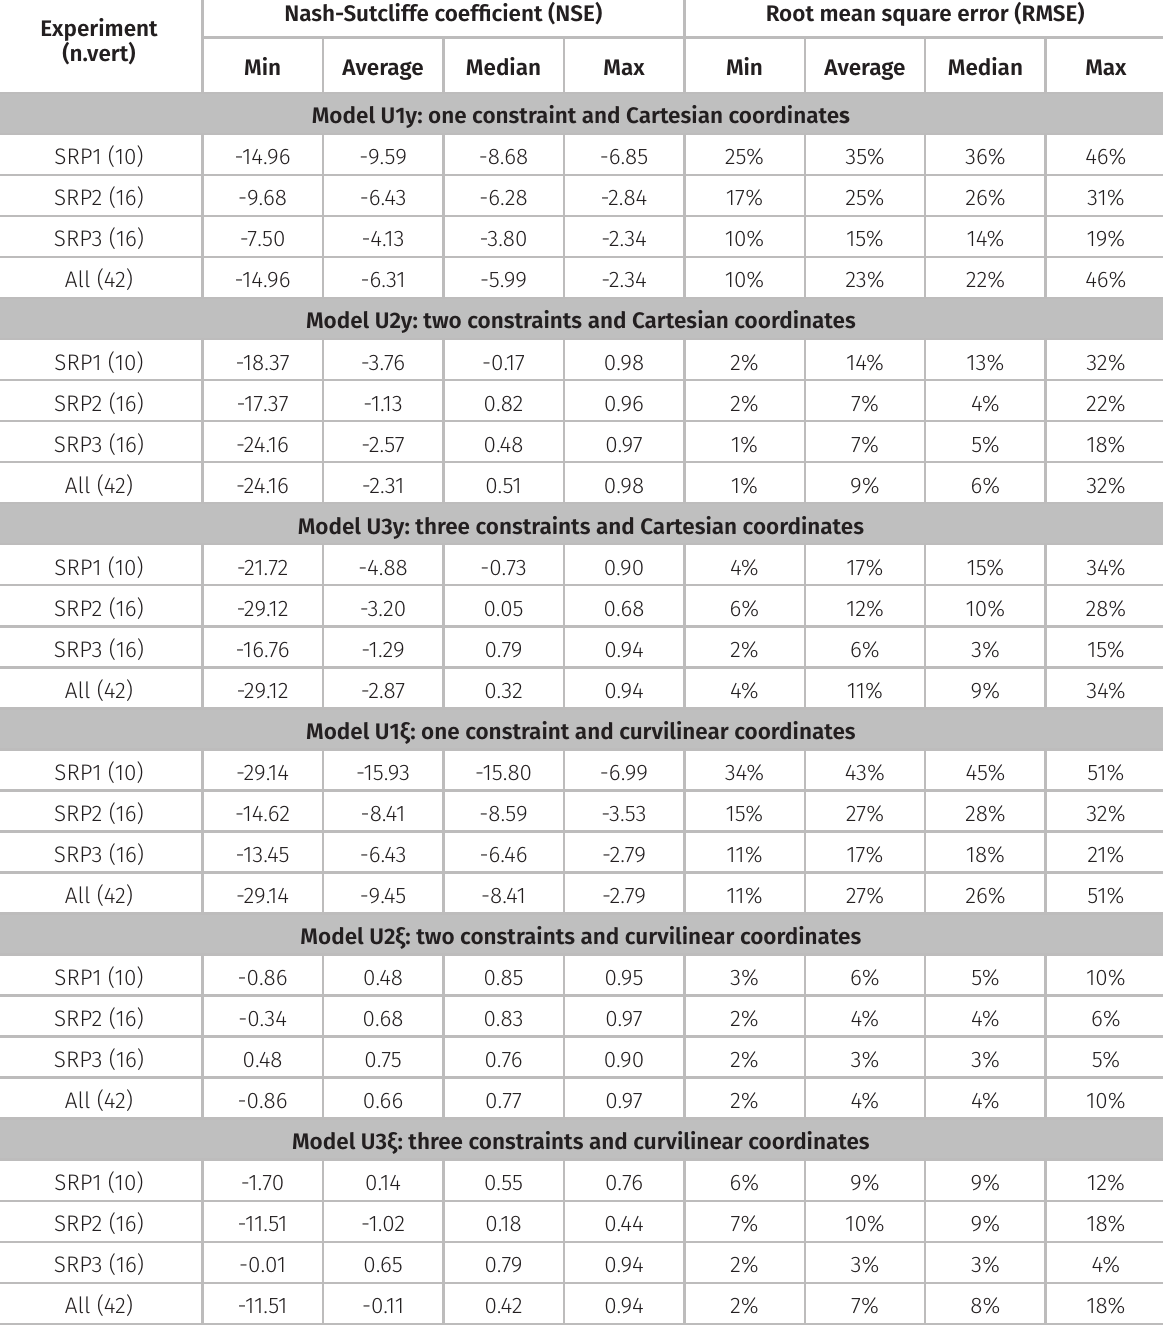
Table II. Model performance of the velocity-field simulations for the 42 vertical profiles of three experiments: SRP1, SRP2, and SRP3. Experiment